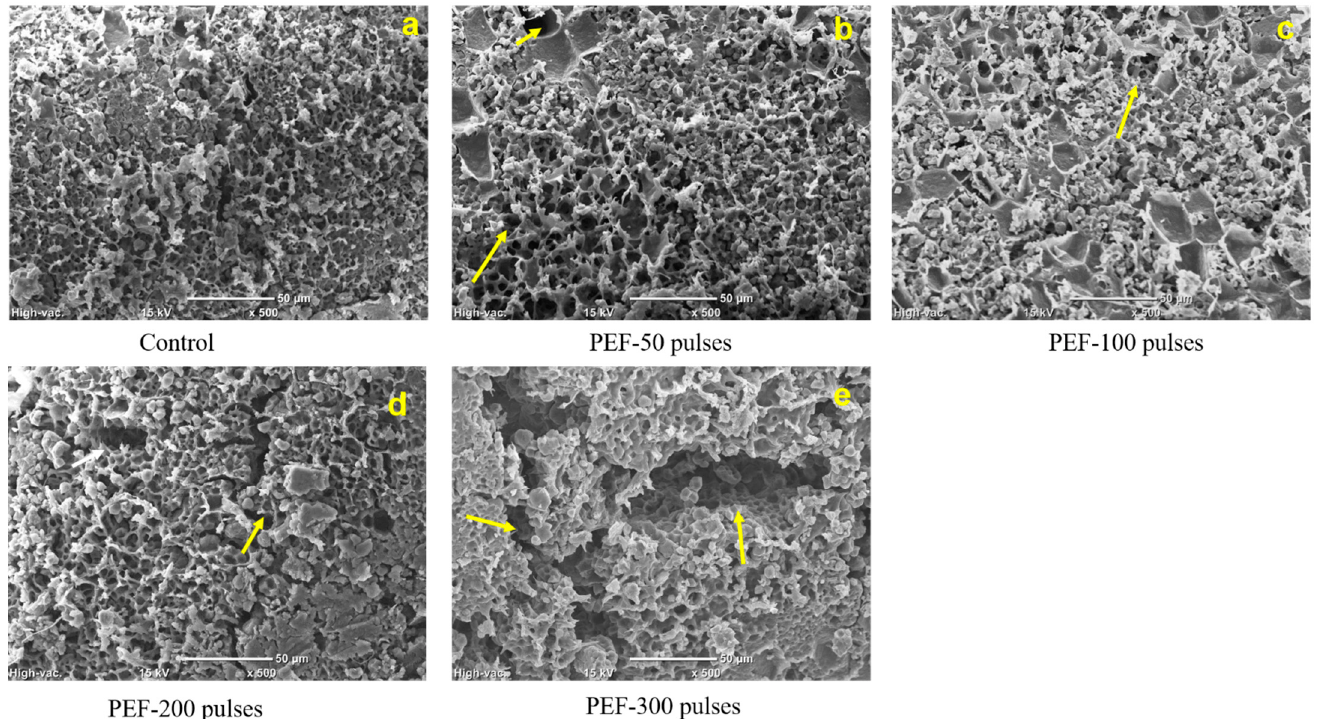
Figure 1. Scanning electron microscopy (SEM) images of pre-soaked glutinous rice grain surface without PEF treatment (Control, a ), and with 50 ( b ), 100 ( c ), 200 ( d ), and 300 ( e ) pulses of PEF treatment. Arrows indicate the pores or cavity on PEF treated rice grain surface. The SEM images captured for all samples provided a × 500 magnification and used scale bar of 50 μ m.